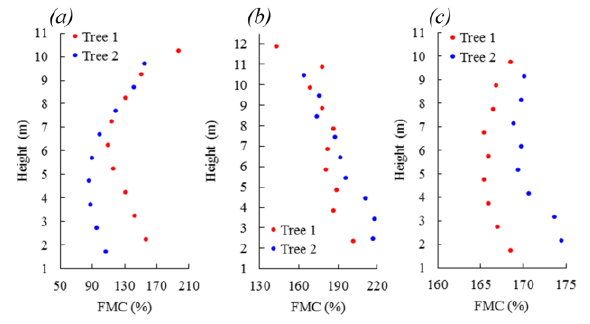
Figure 4. FMC vertical profile for six trees in the plot: (a) Swedish Whitebeam trees 1 and 2, (b) Ash trees 1 and 2, and (c) Holly trees 1 and